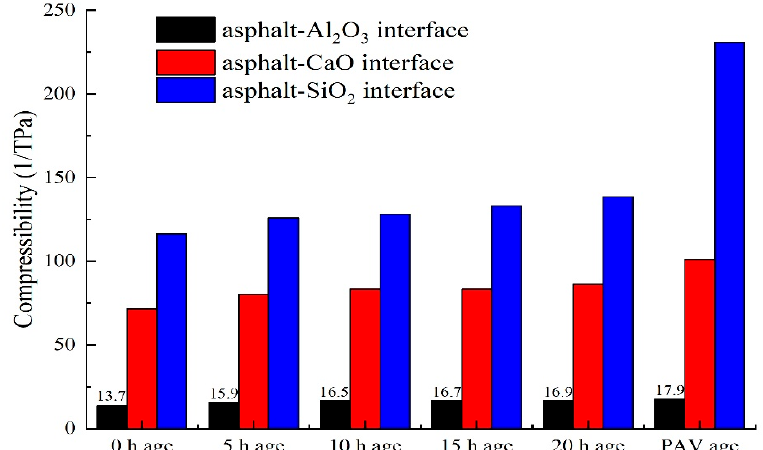
Figure 4. Compressibility of the asphalt-binder-aggregate mineral interface.